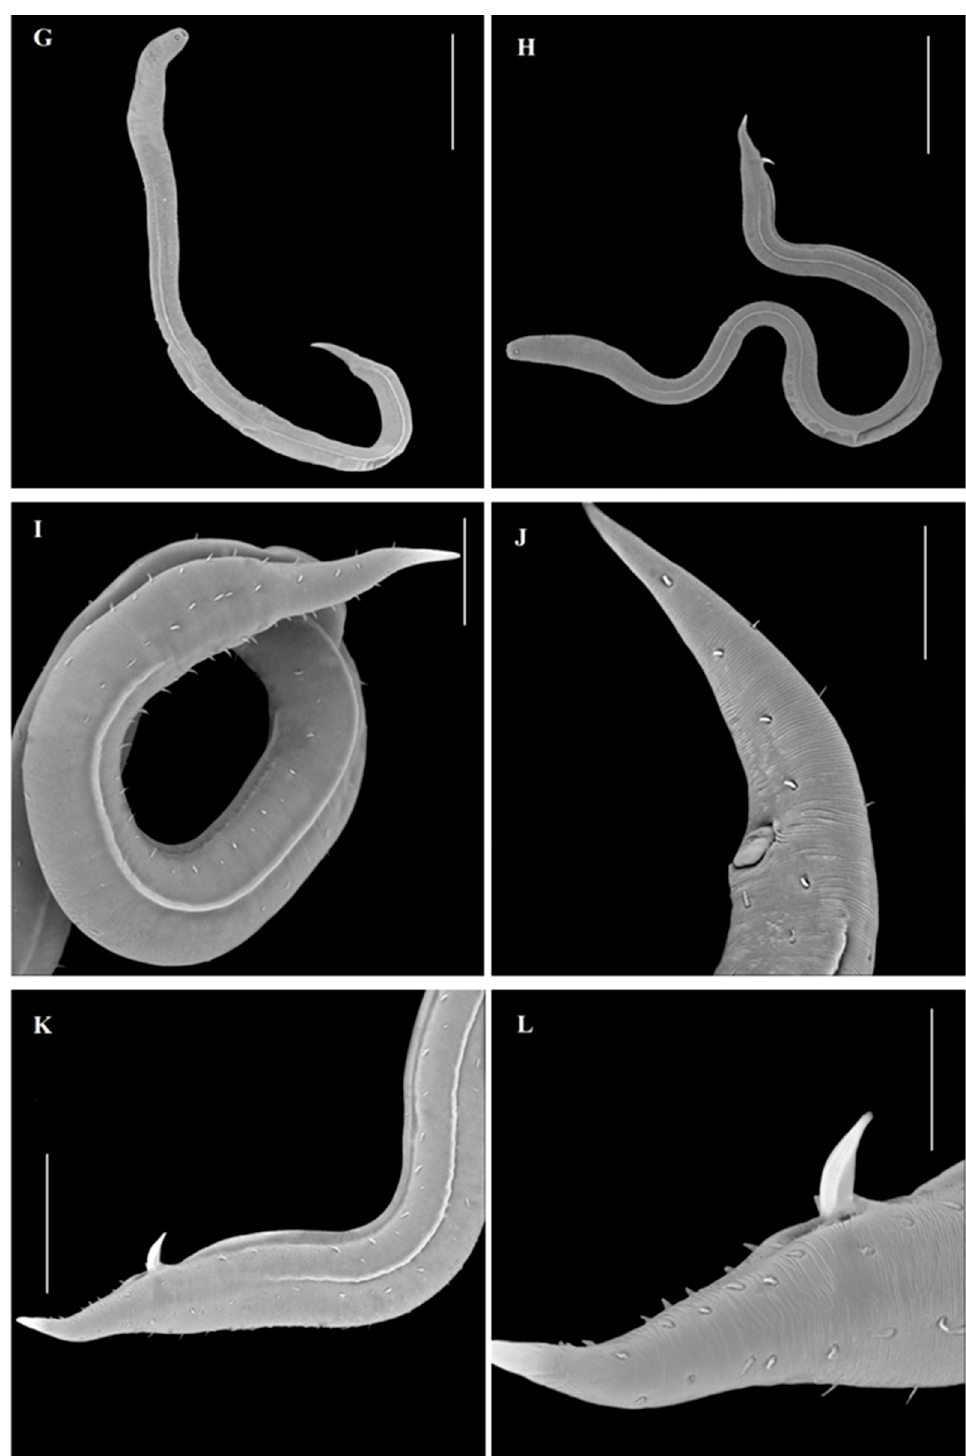
Figure 1. Pseudochromadora gomoi sp.n. SEM images—( A ) detail on the head structure (lip, suture and main cephalic region of the head) (male); ( B ) detail of outer labial and body setae; ( C ) fragment of constrictor cuticle ring in the anterior body part of a juvenile female; ( D ) detail on the cheilorabdhia and related mouth structure; ( E ) female: entire body; (F) female: cloacal and tail region; ( G ) male: entire body; (H) male: detail of tail and spicule region; and (I) male: detail on ventral and lateral alae in the posterior body region. Scale: ( B , F ): 10 μ m; ( A , C , D , E ): 20 μ m; ( J , L ): 30 μ m; ( I ): 50 μ m; ( K ): 80 μ m; and ( G , H ): 200 μ m.